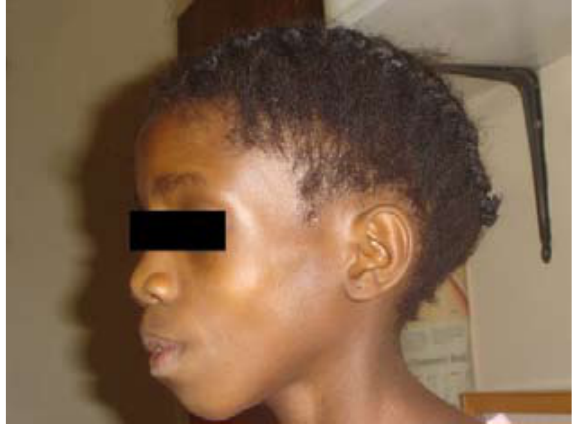
Fig. 6. Severe LA of the face, side view.